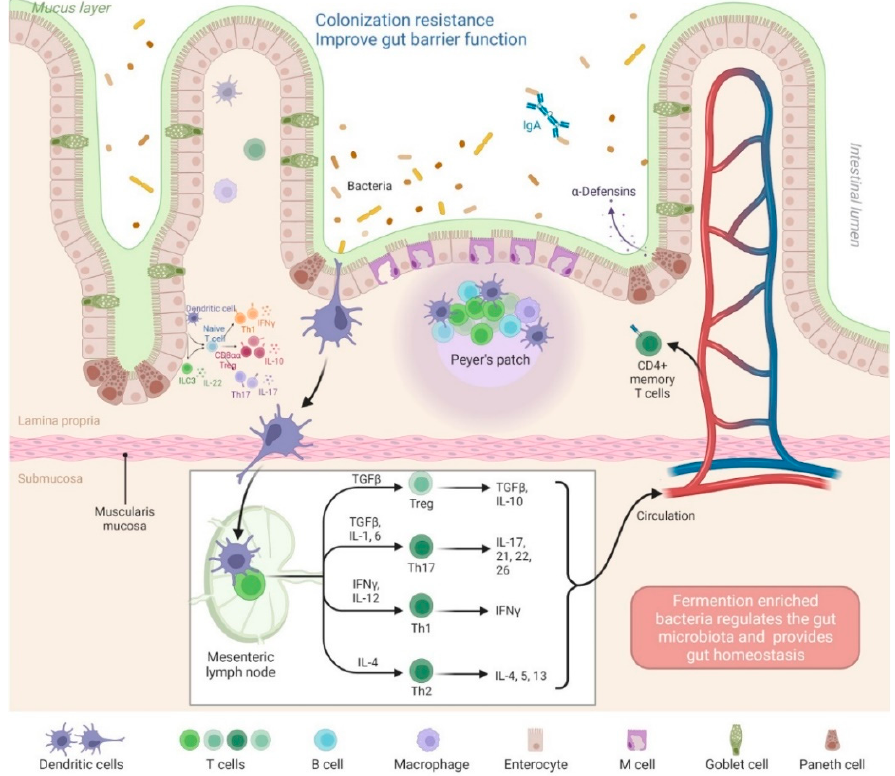
Figure 3. The figure illustrates that fermentation-enhanced bacteria control the microbiota in the gut and maintain intestinal balance.